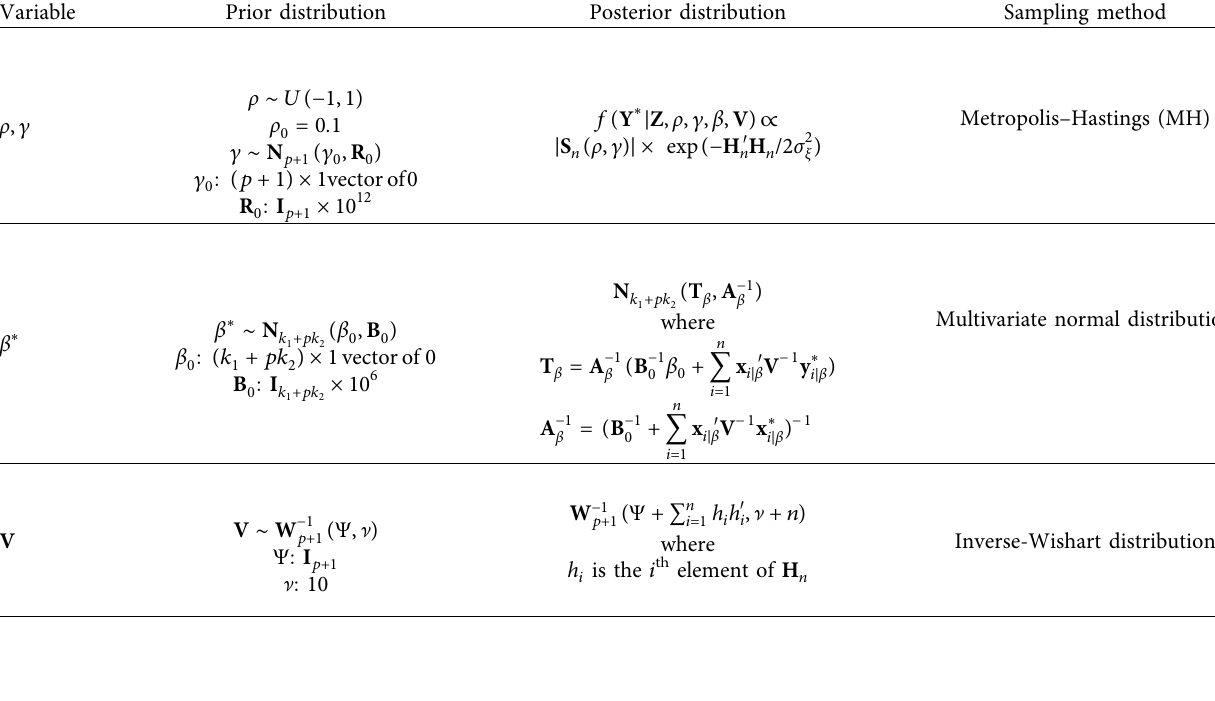
Table 3: Parameters’ posterior